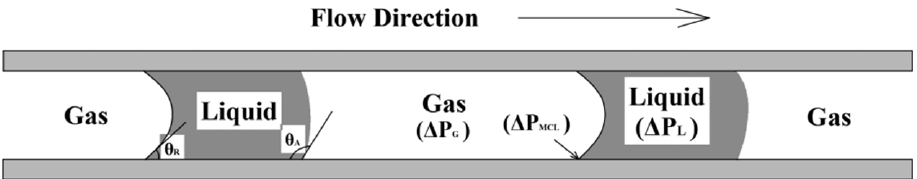
Figure 7. Frictional pressure drop of moving contact line.